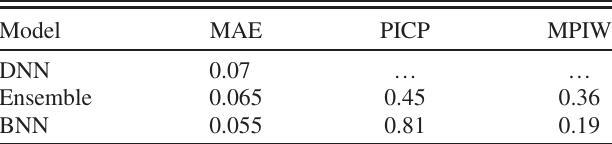
TABLE III. Details of wide scans over features for the LCLS-II injector